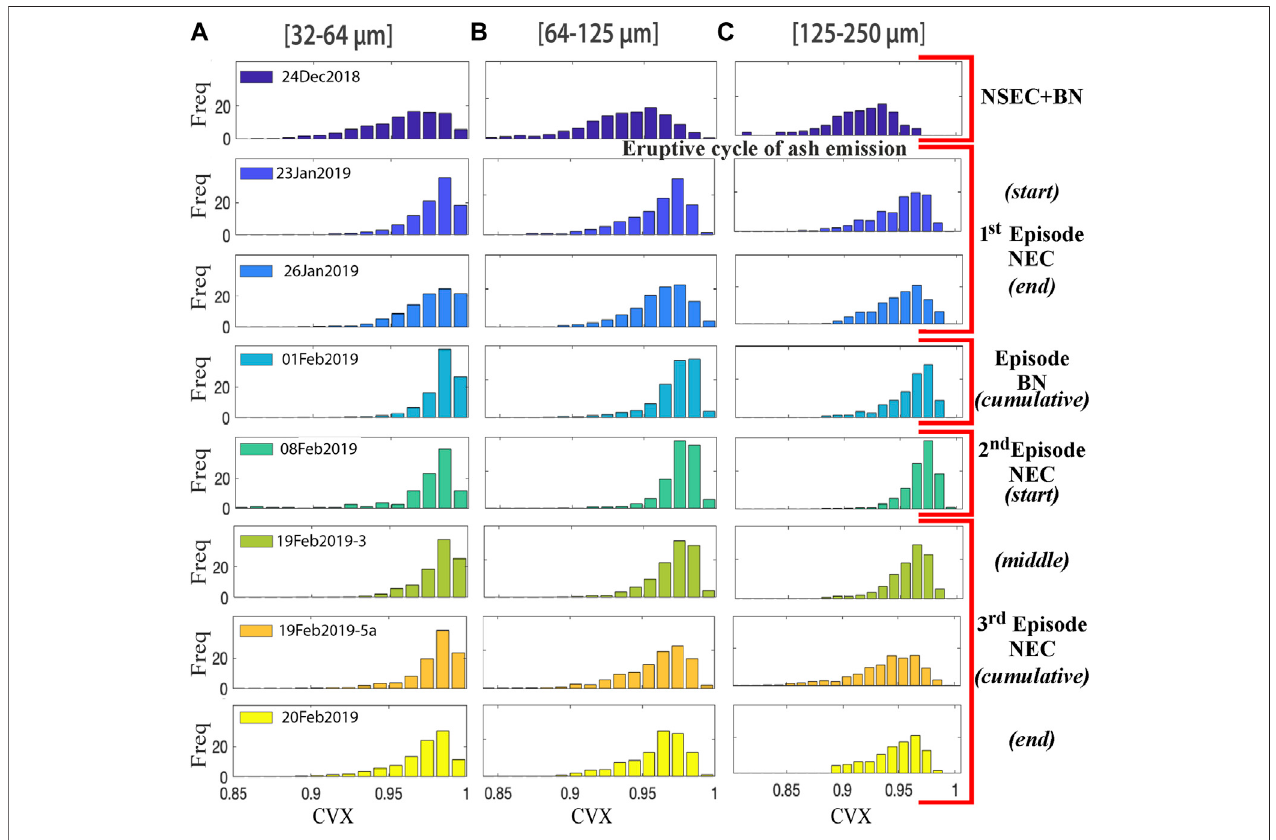
FIGURE 4 | Frequency distributions of Convexity (CVX) values for particles comprised three different class size intervals: (A) 32 – 64 μ m; (B) 64 – 125 μ m; (C) 125 – 250 µm.